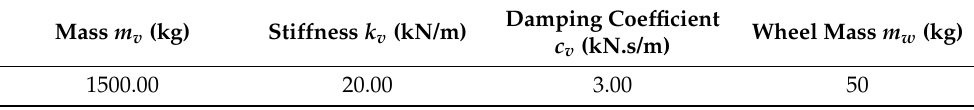
Table 3. Properties of the instrumented